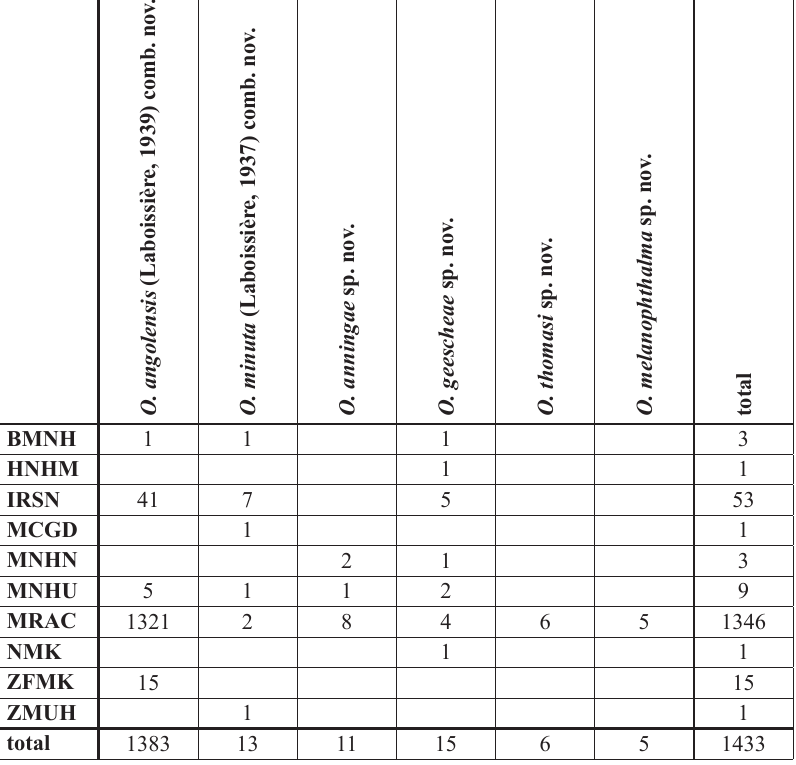
Table 1. Numbers of examined specimens in the studied